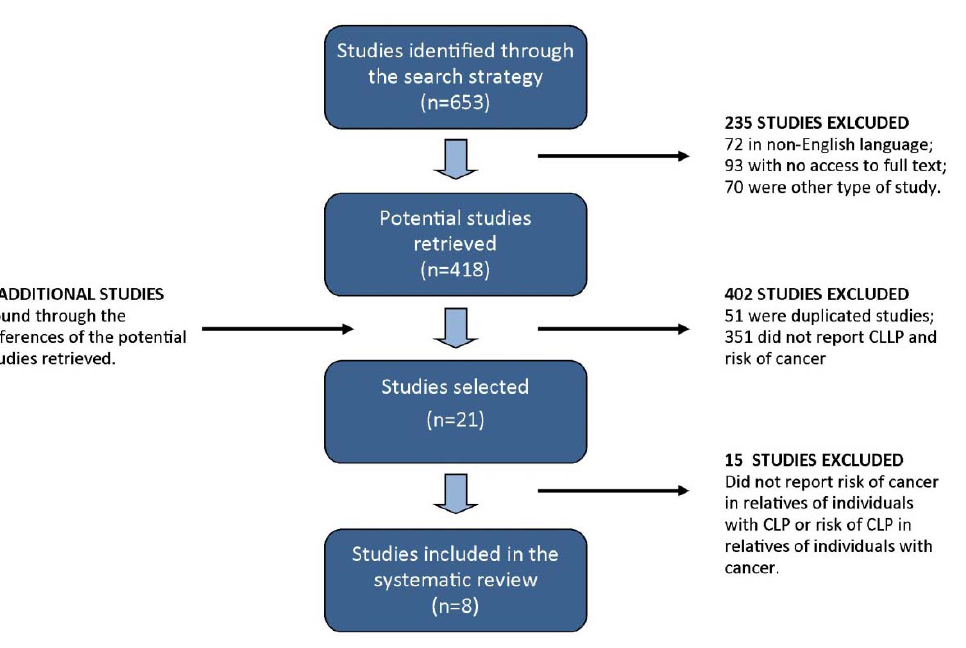
Figure 1: Flowchart of the studies included and